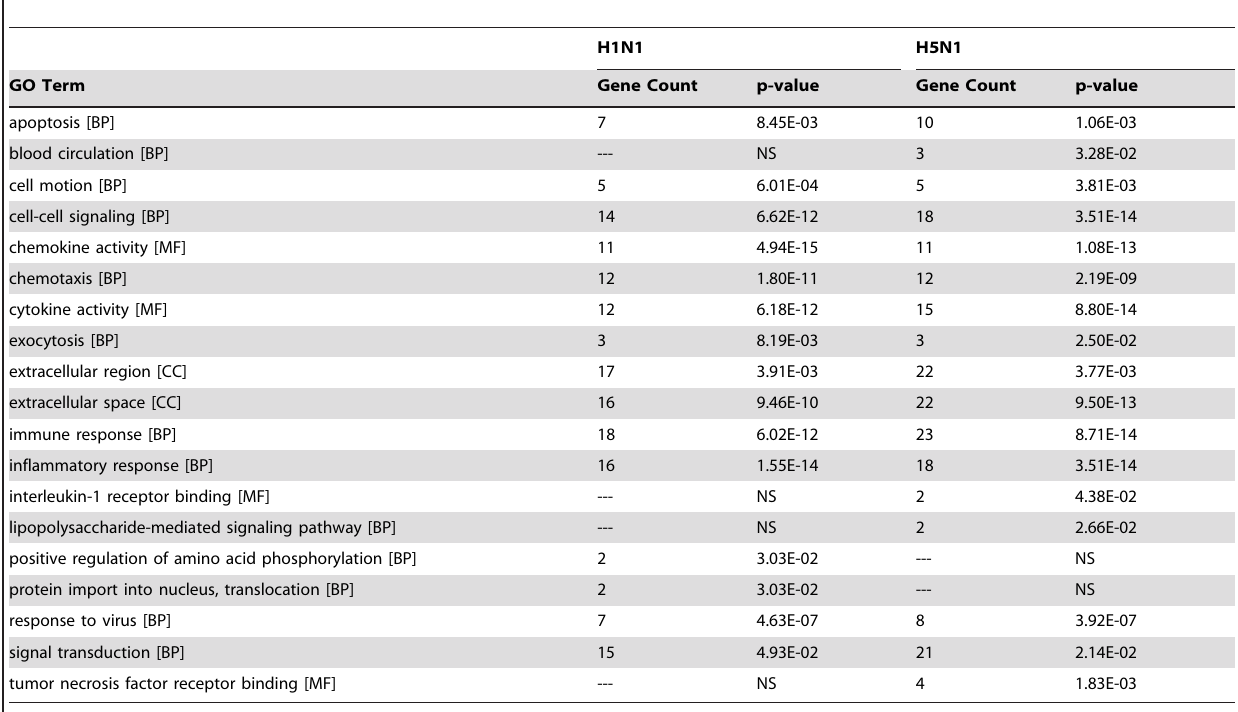
Table 2. Significantly enriched Gene Ontology terms in the response to H1N1 and H5N1 infection.